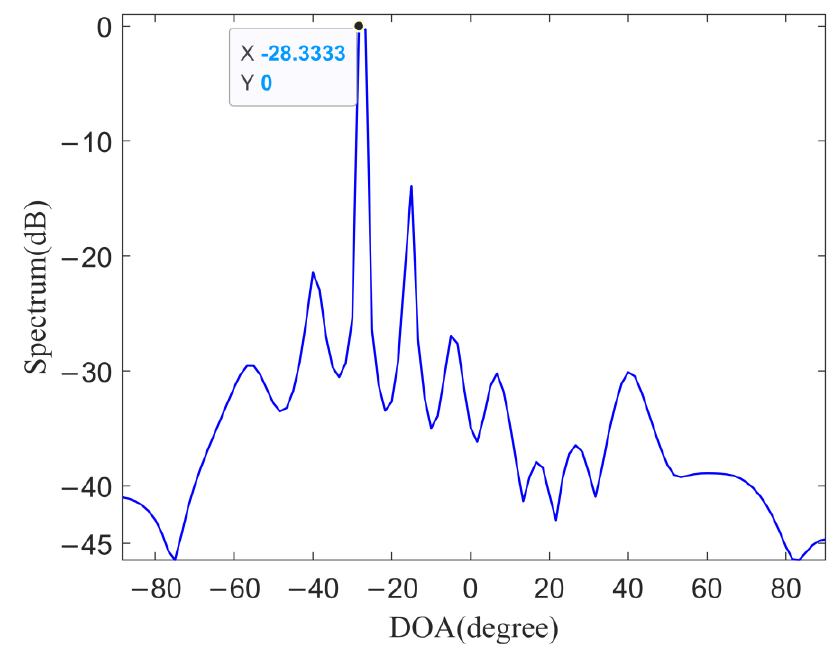
Figure 16. The first strong co-channel interference spatial spectrum.